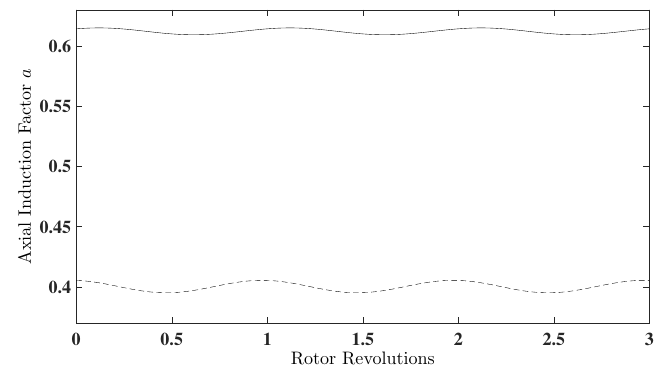
Figure 12. Time evolution of the axial induction factor a at 90% of the blade span for an NREL-5MW turbine. The dashed line depicts a for a start-up scenario at 6 m/s wind velocity and 7.9 rpm. The solid line represents a when the wind velocity suddenly drops from its nominal value of 11.4 m/s to 5.8 m/s, while operating at the nominal angular speed of 12.1 rpm.